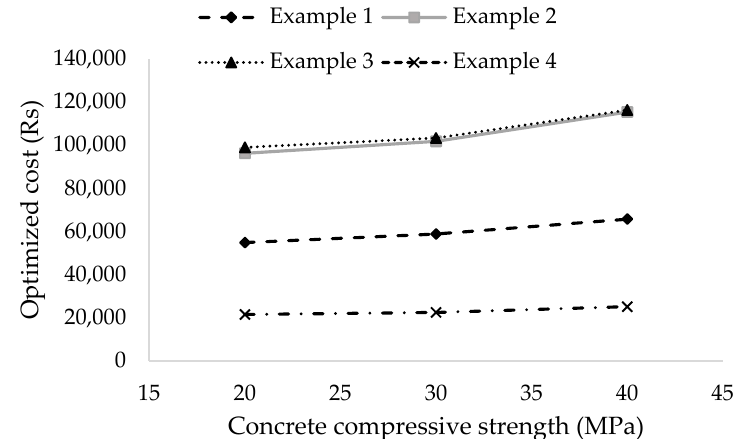
Figure 13. Effect of concrete compressive strength on cost.